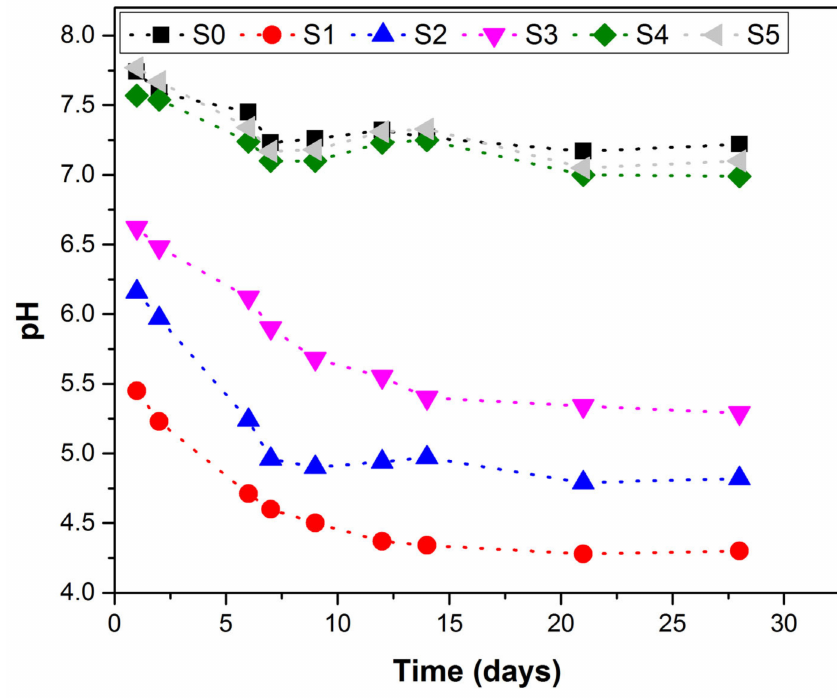
Figure 5. pH evolution over time for studied